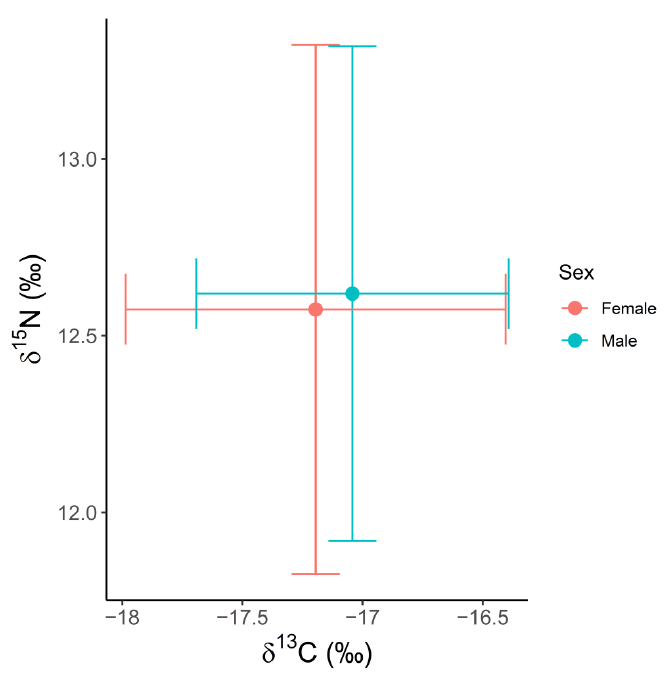
Figure 2. Carbon and nitrogen ( δ 13 C and δ 15 N) stable isotope biplot from skin samples of male ( n = 57) and female ( n = 68) long-finned pilot whales ( Globicephala melas edwardii ) stranded on the New Zealand coast between 2009 and 2017. Table 3. Mean and standard deviations ( ± 1 SD) of carbon, nitrogen, and sulphur ( δ 13 C, δ 15 N